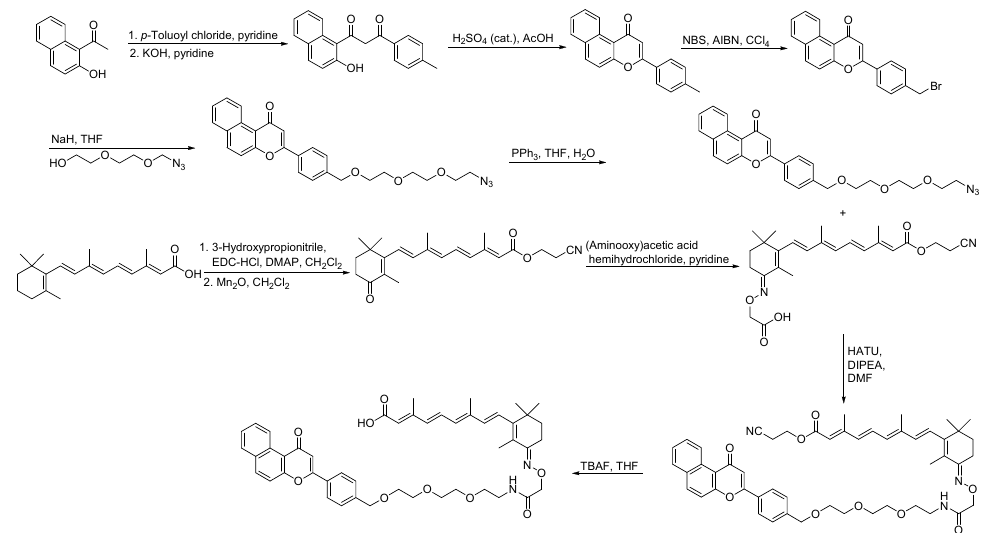
[48] Table 6. Natural product targets 13–16.